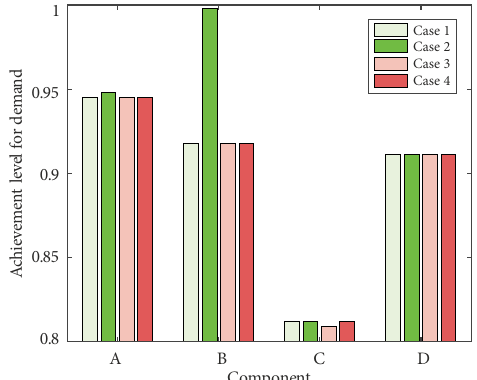
Figure 8. Demand achievement levels of components A-D for four cases of